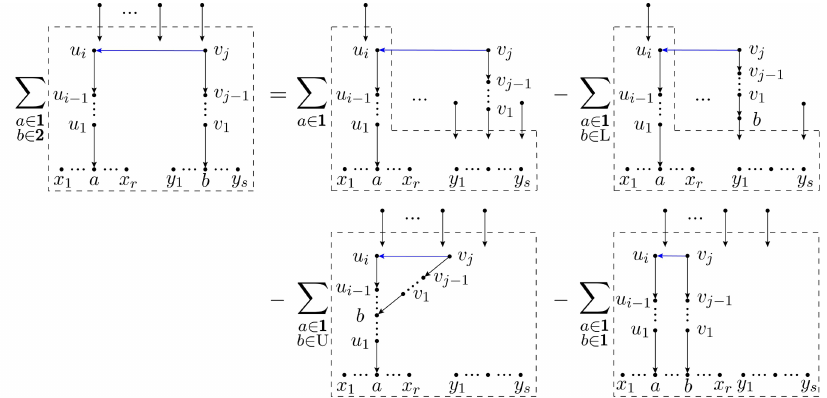
Figure 4 . Transformation-2 of spanning forests (The set { u 1 , u 2 . . . u i } is denoted by U , and the set of gravitons that are not in set { u is denoted by L .) Each graph also 1 , u 2 . . . u i , v 1 , v 2 , . . . v j } imply a sum over all possible spannning forests generated by nodes outside the boxed